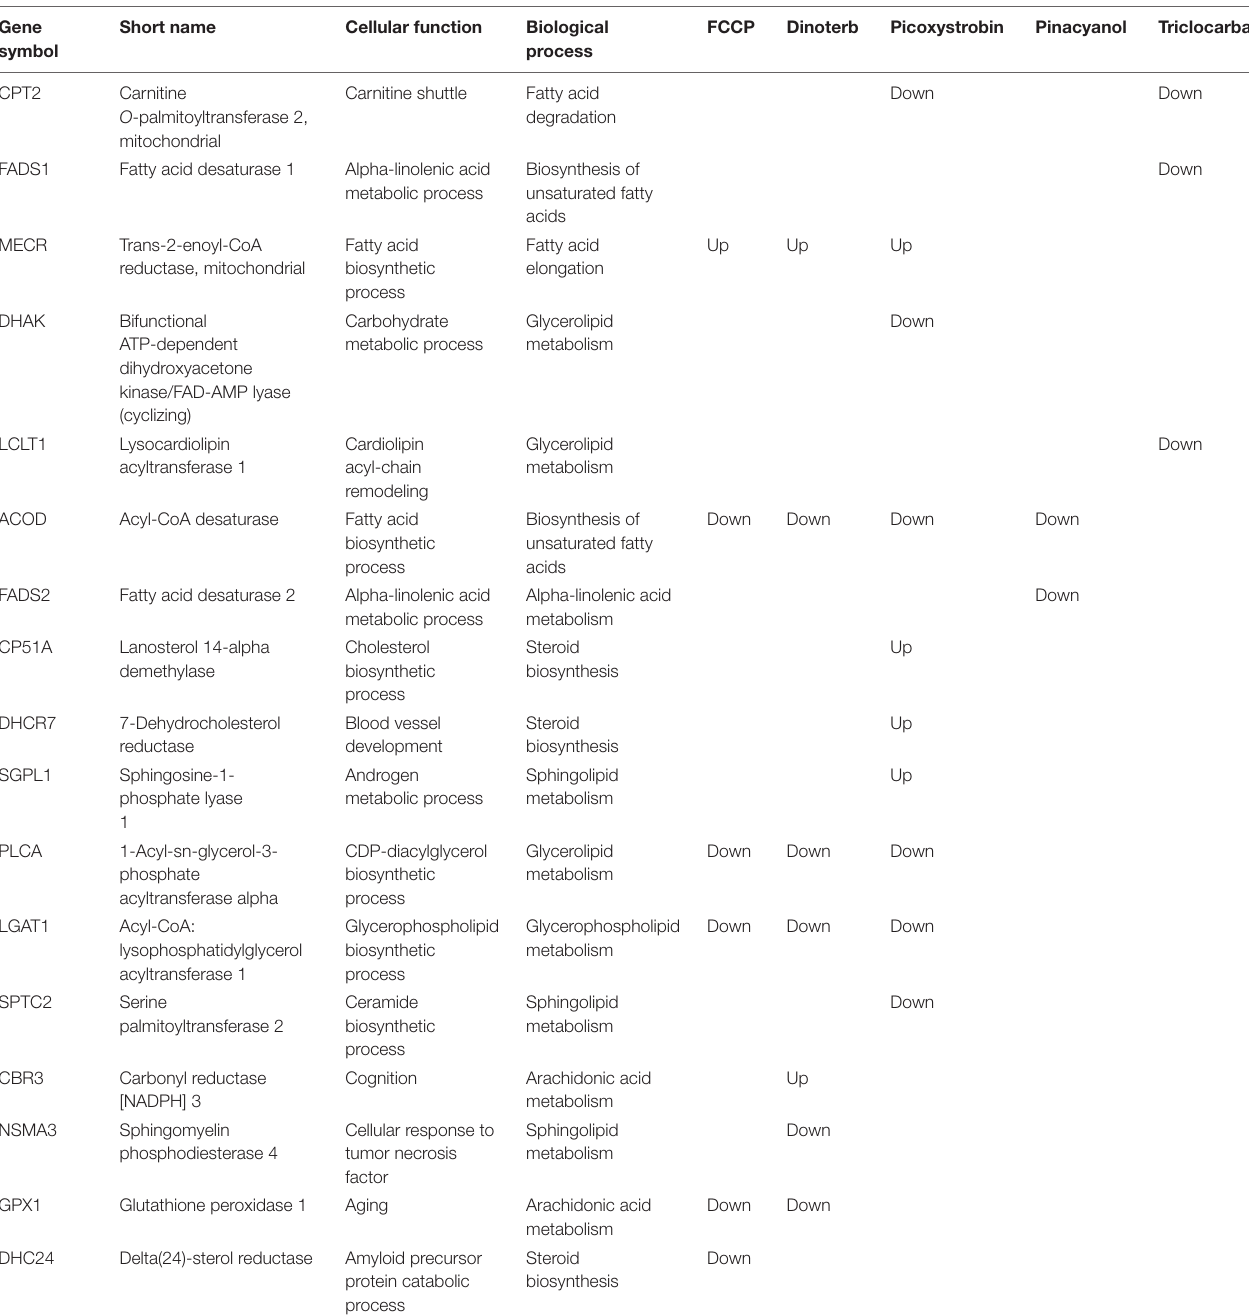
TABLE 2 | Lipid metabolism related